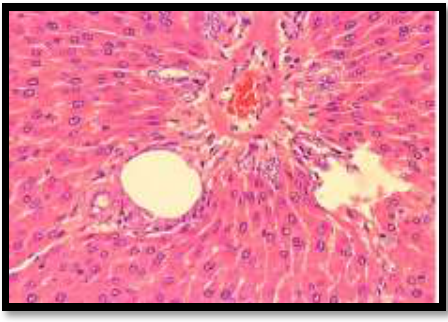
Figure 3b: Photomicrograph of Sudan black stained 5 µm thick frozen liver section showing hepatocytes without fat droplet, nucleus, and Central Vein (CV), of rat on control diet (group 1) at